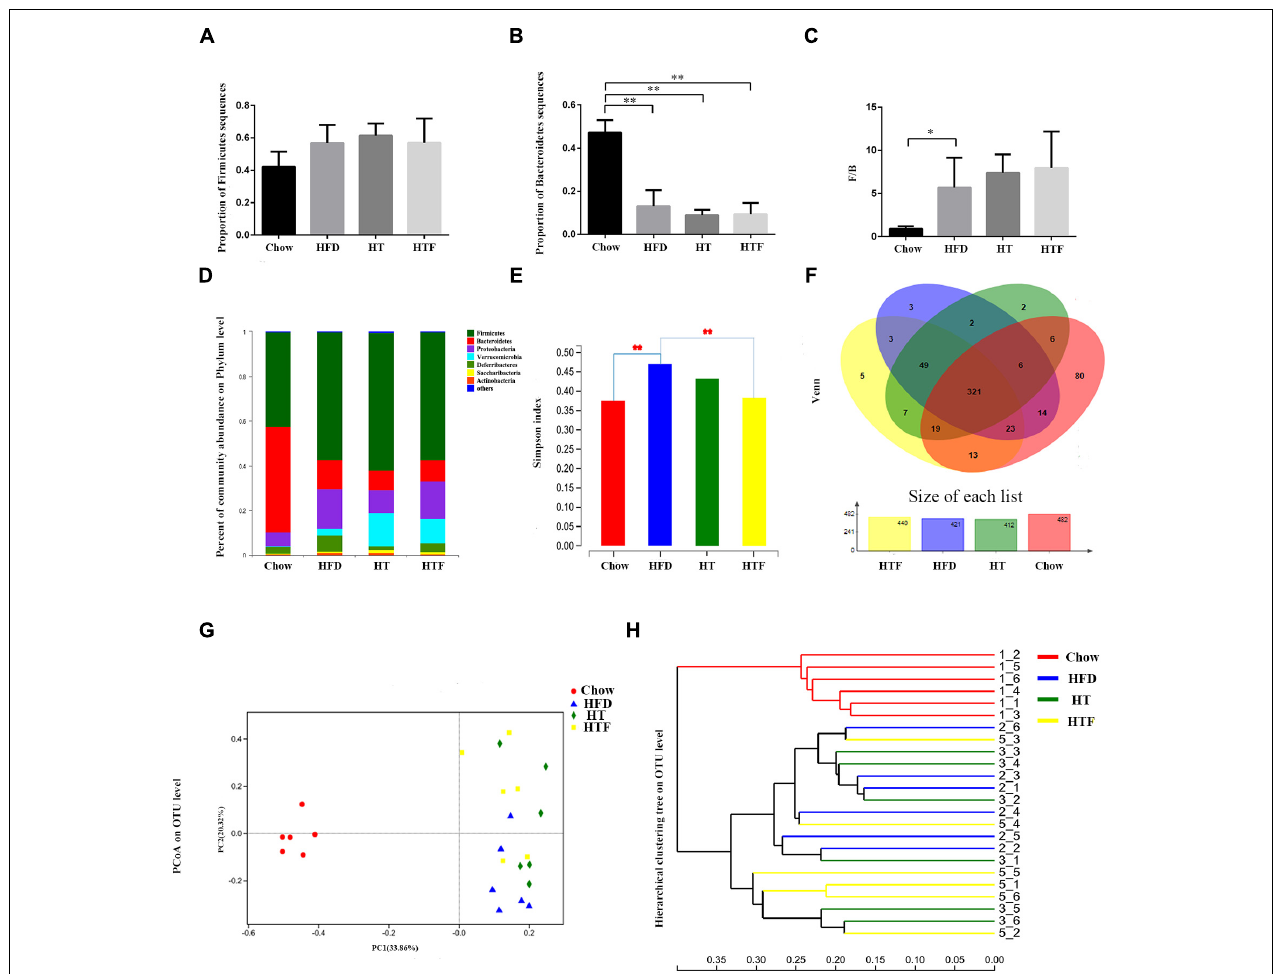
FIGURE 4 | HT and HTF alters microbiota structure in HFD-fed mice. Microbiota composition in feces of chow-fed mice and HFD mice treated with HT and HTF were analyzed using next generation sequencing ( n = 6 for each group). Proportion of Firmicutes (A) , Proportion of Bacteroidetes (B) , F/B (C) , Graph bars with statistically significant results ( P ≤ 0.05) based on one-way ANOVA analysis followed by Tukey’s honest significant difference post hoc tests. Plots shown were generated using the weighted version of the bray curtis-based Bacterial taxonomic profiling in the phylum level of intestinal bacteria from each group (D) Simpson index (E) were analyzed using unpaired two-tailed Student’s t -test. Venn chart (F) , PCoA (G) and Hierarchical clustering tree on OTU level (H) ( ∗ P ≤ 0.05; ∗∗ P ≤